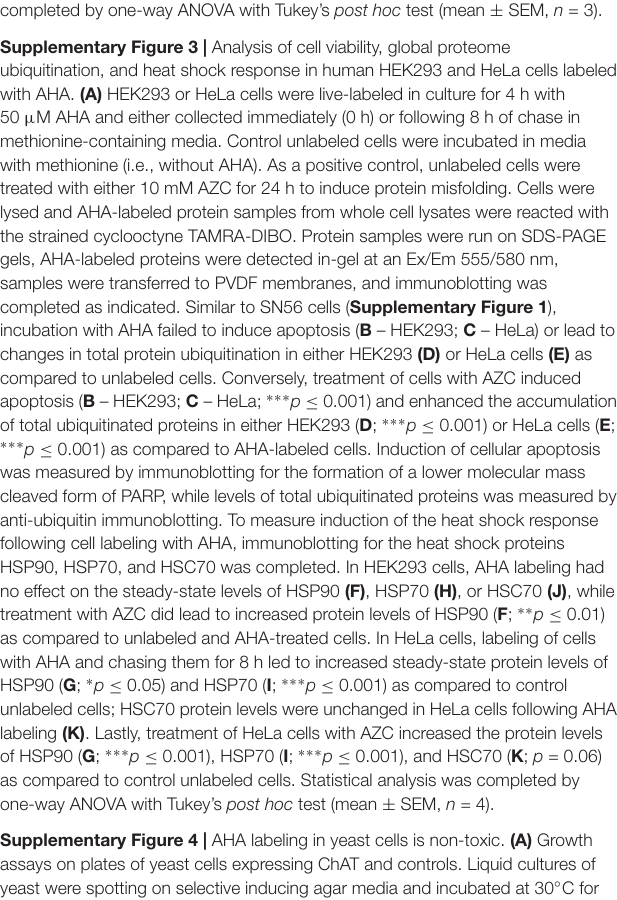
Supplementary Figure 1 | Analysis of cell viability, global proteome ubiquitination, and heat shock response in mouse cholinergic SN56 cells labeled with AHA. (A) SN56 cells were live-labeled in culture for 4 h with 50 µ M AHA and either collected immediately (0 h) or following 8 h of chase in methionine-containing media. Control unlabeled cells were incubated in media with methionine (i.e., without AHA). Cells were lysed and AHA-labeled protein samples from whole cell lysates were reacted with the strained cyclooctyne TAMRA-DIBO. Protein samples were run on SDS-PAGE gels, AHA-labeled proteins were detected in-gel at an Ex/Em 555/580 nm, samples were transferred to PVDF membranes, and immunoblotting was completed as indicated. In support of previous studies